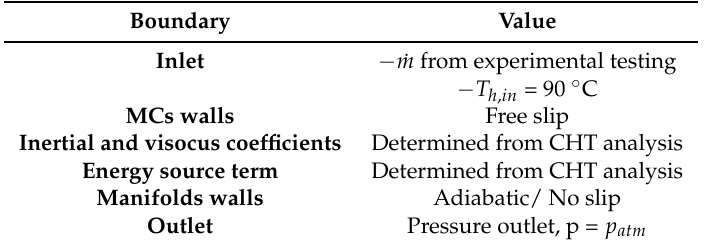
Table 3. Boundary conditions used in the porous model for µ Hx.